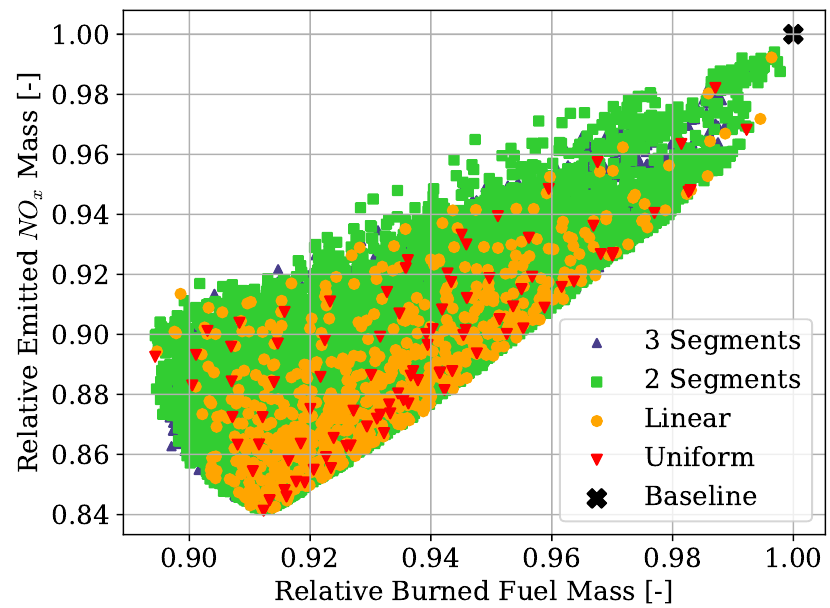
Figure A2. Objective space of Climb and cruise hybridisation